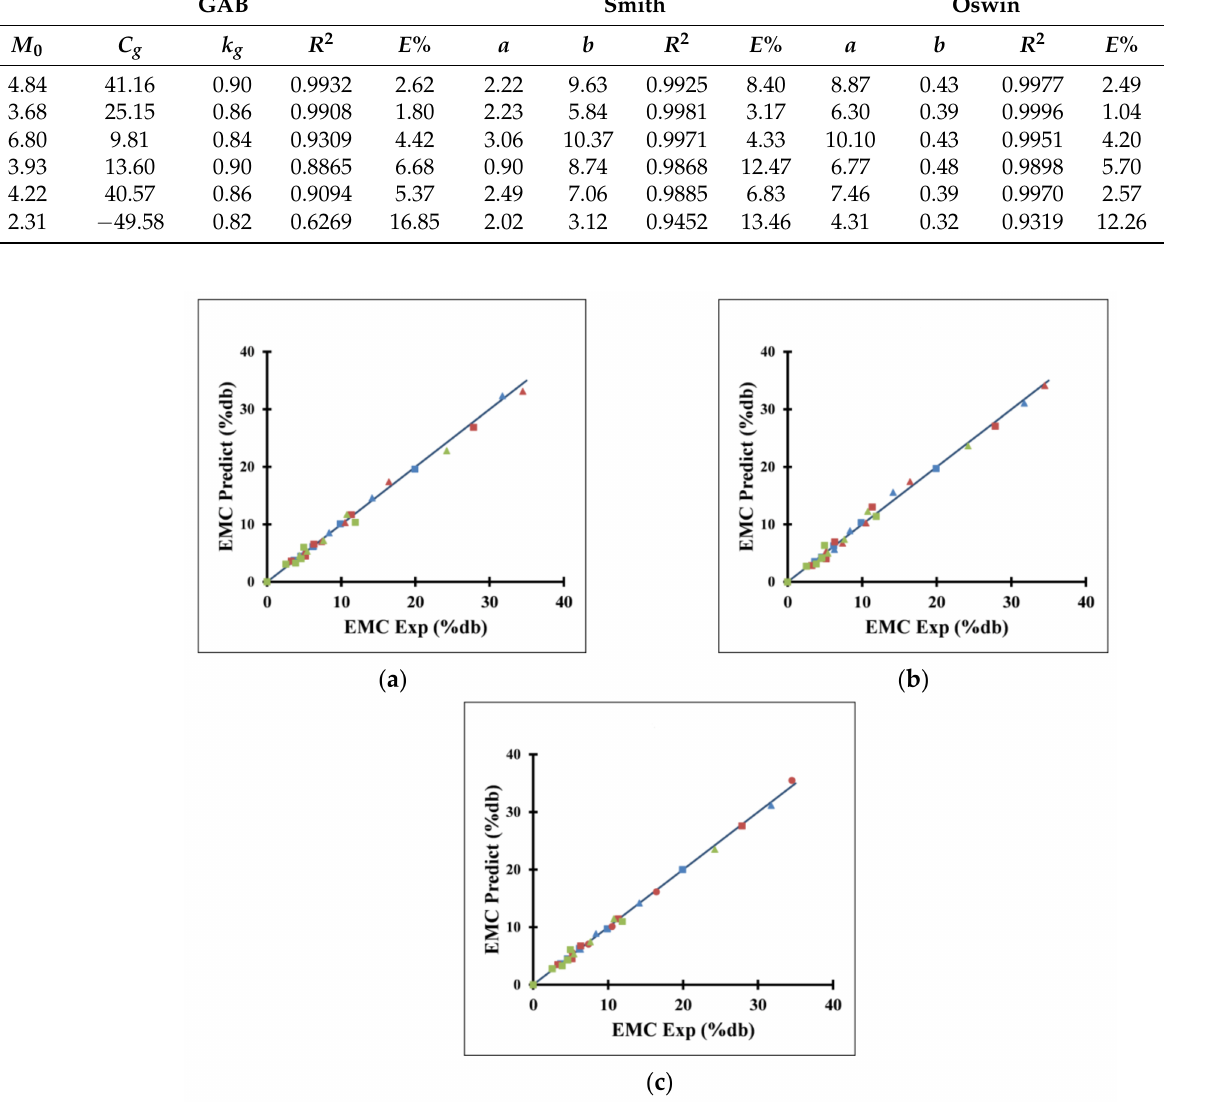
Figure 3. Comparison of equilibrium moisture content (EMC) from experimental and EMC prediction for each model ( a ) GAB, ( b ) Smith, and ( c )